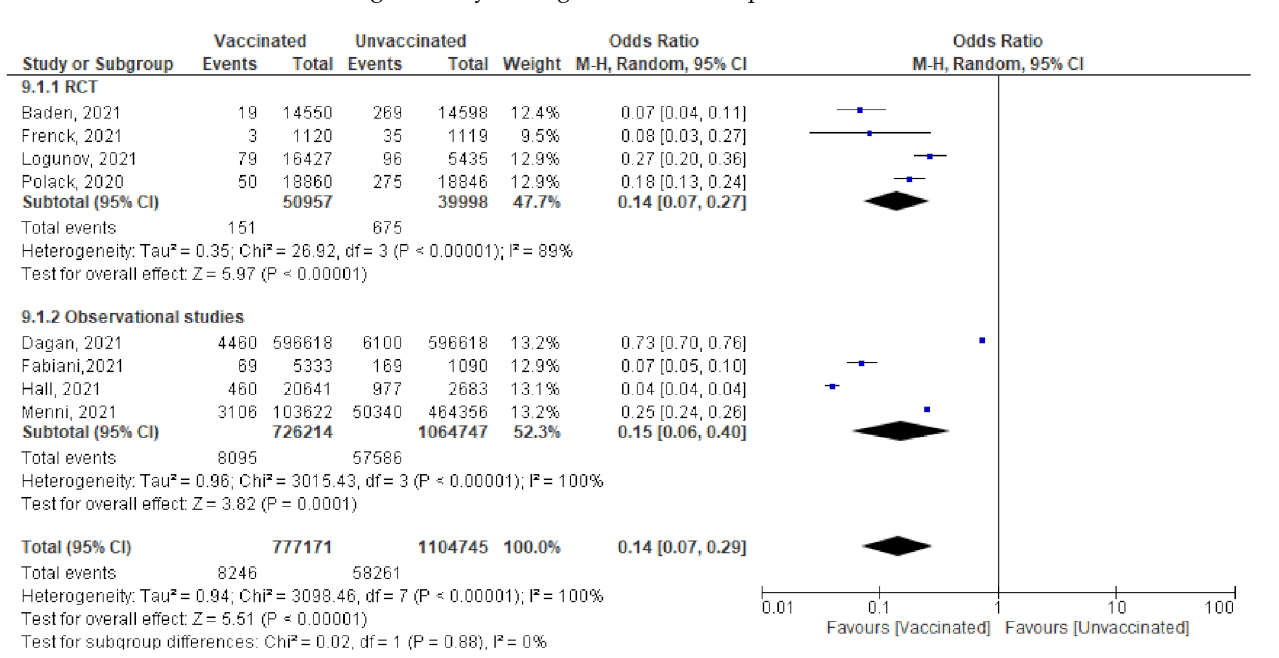
Figure 8. Incidence of all SARS-CoV-2 cases after 1st dose of